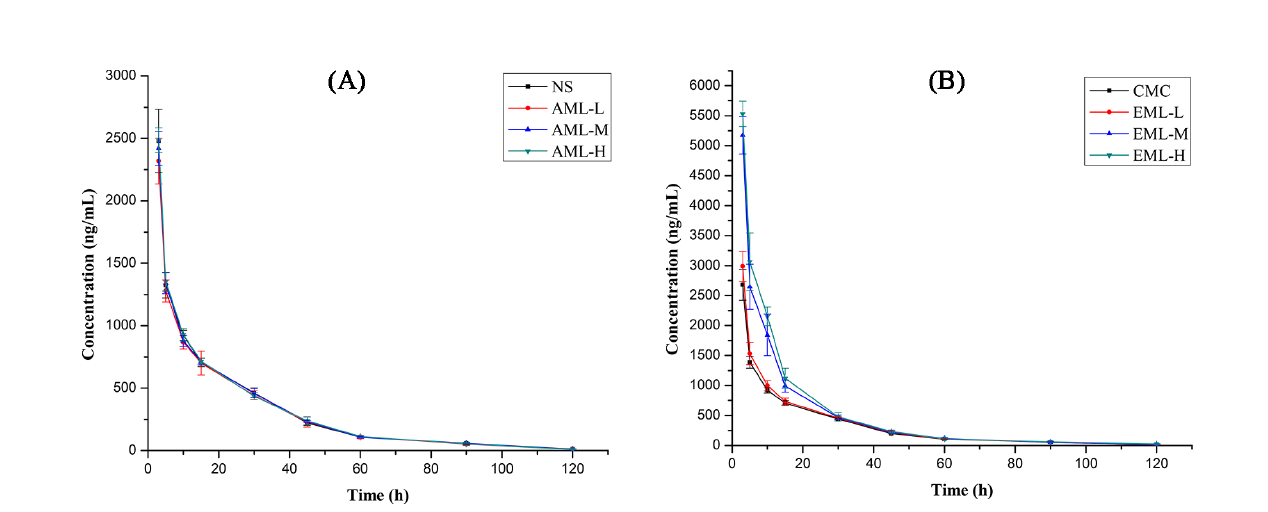
FIGURE 5 – Mean plasma concentration-time profiles of omeprazole in rats pre-treated with AML (A) and EML